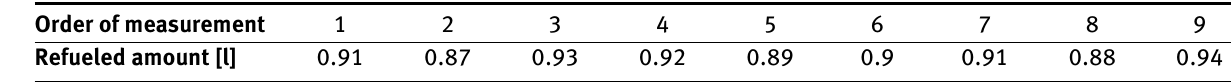
Table 5: Results of deviation measurement during automatic pump gun shutting off Order of measurement